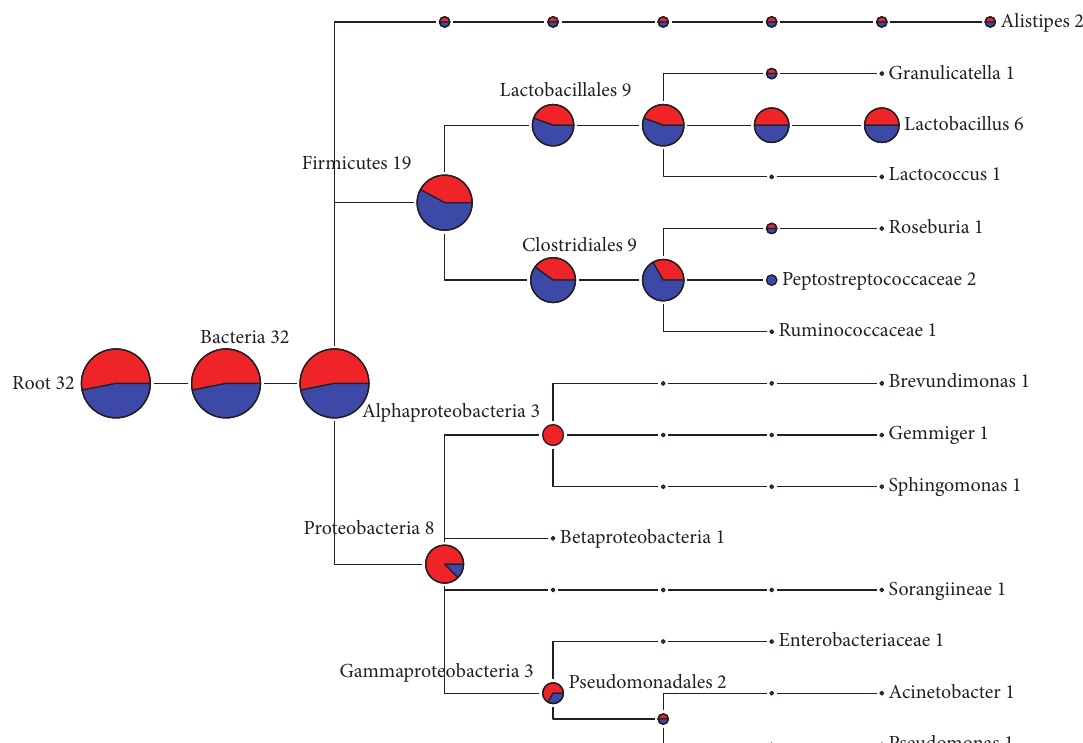
Figure 4: Bacterial diversity of turkey ileal mucosal bacteriome. Only the genera represented by ≥ 5 OTUs each were shown, and the size of each node reflects the total number of OTUs. The relative proportion of taxa from the two pyrosequencing runs was shown by different colors: red, from the first run; blue, from the second